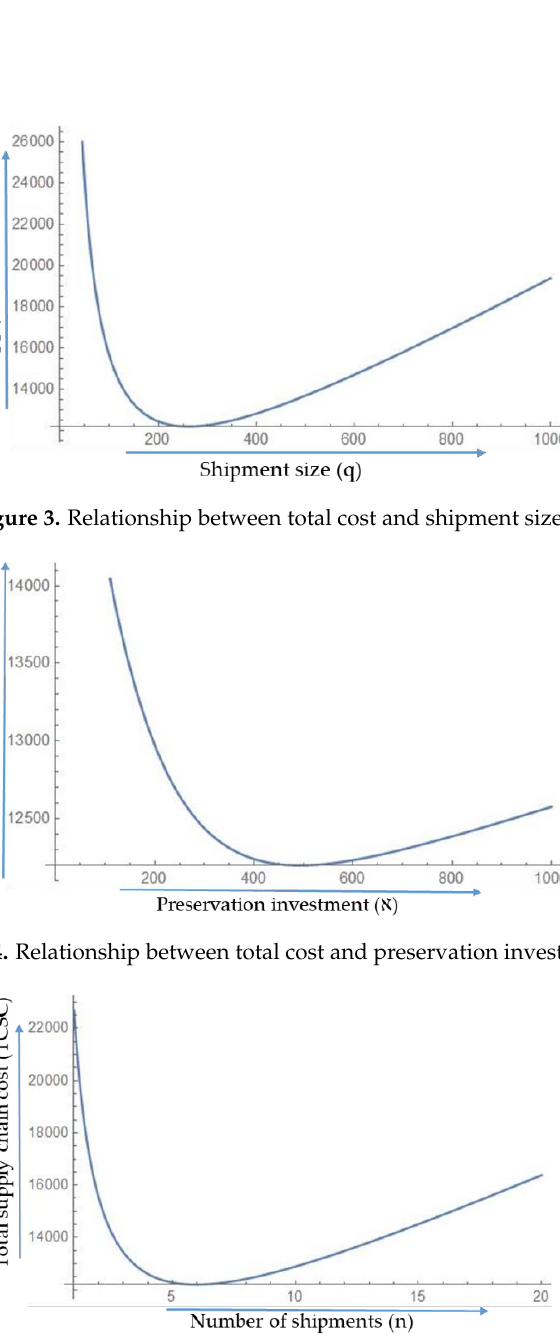
Figure 5. Relationship between total cost and number of shipments.